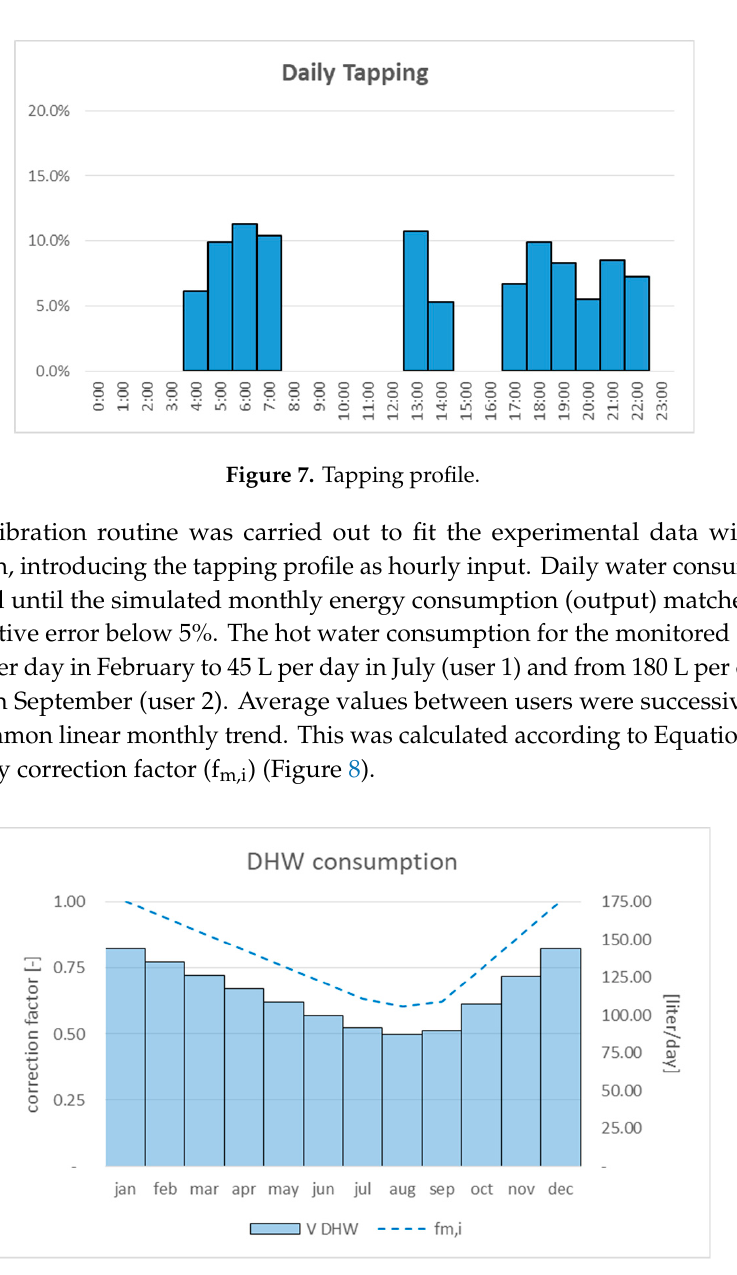
Figure 8. DHW consumption per day at 40 °C for analyzed consumer residential unit.